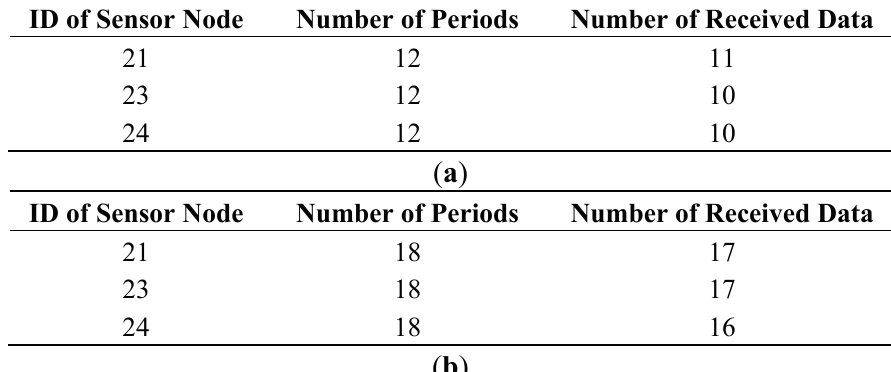
Table 5. Transmission results of field test. ( a ) Statistics of WSN_1; ( b ) Statistics of